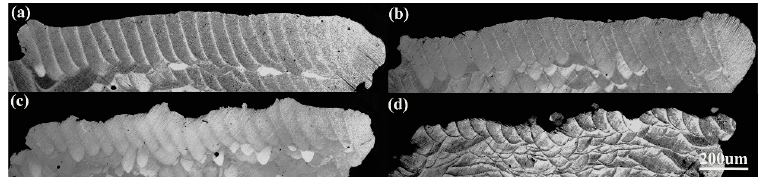
Figure 8. Cross-sectional morphology of molten pool of the struts fabricated by fixed hatch spacing of 0.06 mm and different scanning speed of: ( a ) 1400 mm/s; ( b ) 1800 mm/s; ( c ) 2200 mm/s; and, ( d ) 3000 mm/s.